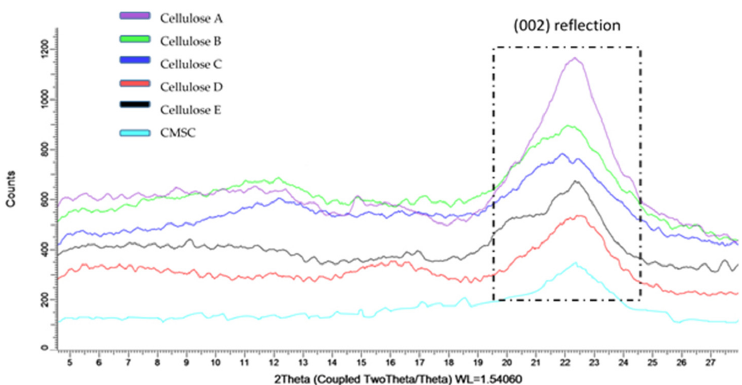
Figure 4. X ‐ ray diffractograms of cellulose A (preparation 1) ( A ); cellulose B (preparation 2) ( B ); cellulose C (preparation 3) ( C ); cellulose D (preparation 4) ( D ); cellulose E (preparation 5) ( E ); CMSC ( F ).